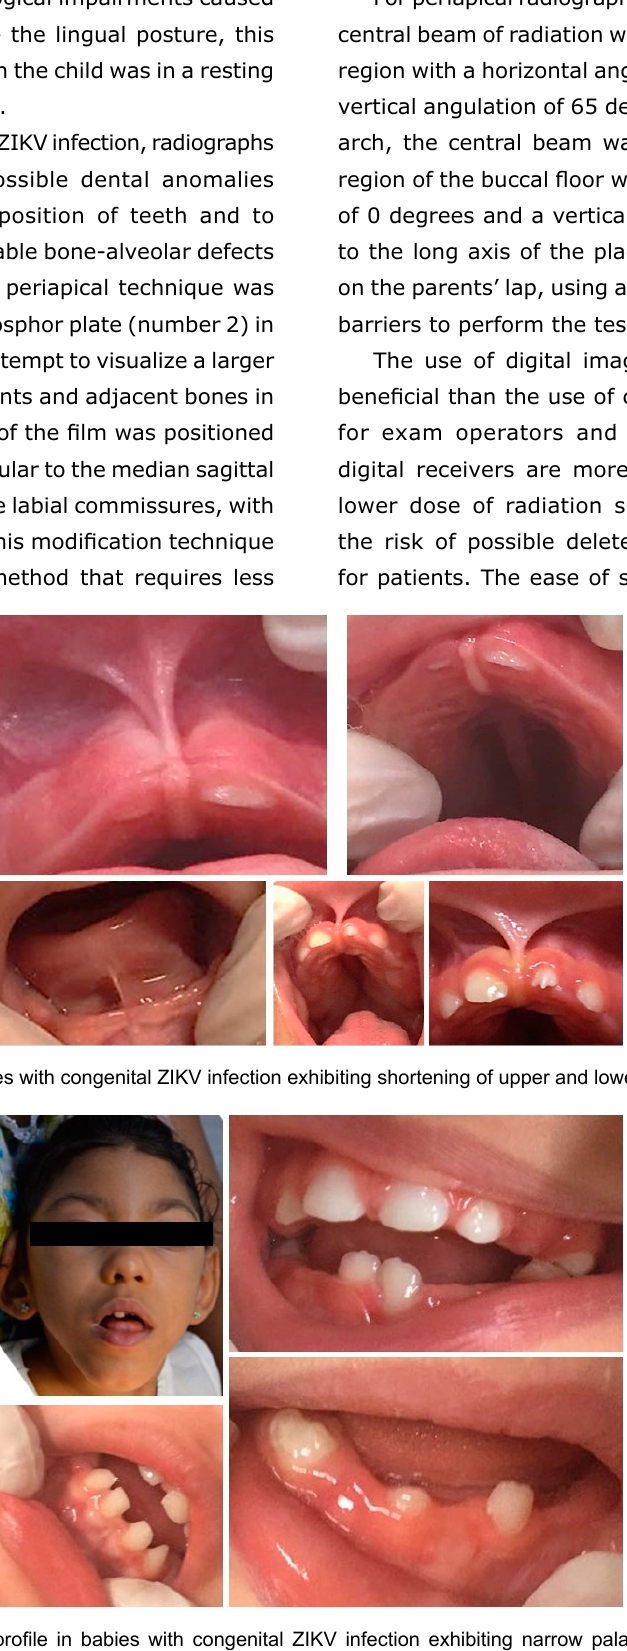
Figure 2- Orofacial and dental profile in babies with congenital ZIKV infection exhibiting narrow palatine vaults and dental eruption